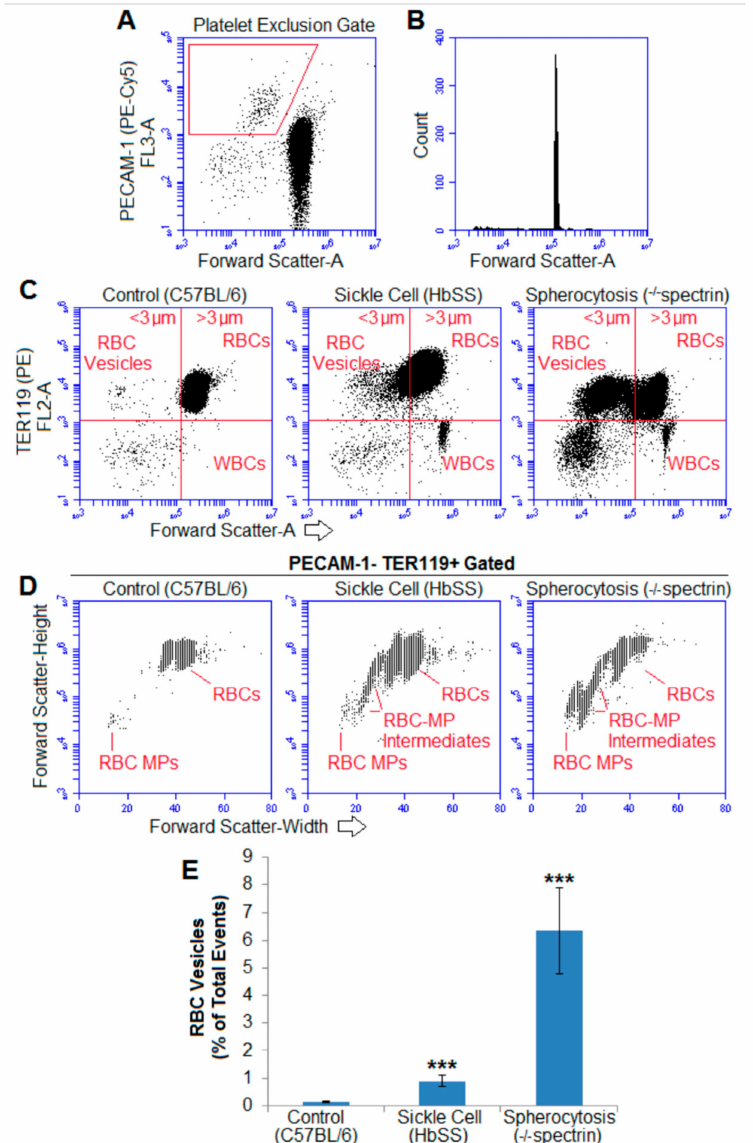
Figure 7. Blood from mouse models of hemolytic anemia contained large and heterogeneously sized vesicles: ( A ) PECAM-1+ platelets and other MPs/MVs were excluded (red trapezoid exclusion gate) and ( B ) 3 µ m beads were used to distinguish vesicles from cells (as murine RBCs are smaller than human). ( C ) Representative (PECAM-1 platelet/MV excluded) whole blood diluted 1:1000 in normal saline with 10% BSA and stained for TER119 in healthy control mice (C57BL/6), mice expressing solely human sickle hemoglobin (HbSS), and mice with deficient spectrin modeling hereditary spherocytosis. ( D ) Representative forward scatter height by width demonstrates heterogeneously sized RBC-MV intermediates in both sickle cell and spherocytosis mouse blood. ( E ) RBC vesicles smaller than 3 µ m made up nearly 1% of all events in the sickle cell mouse blood and over 6% of all events in spherocytosis mouse blood; *** p < 0.001 compared to normal mice; n = 3–5. The blood of both hemolytic mice groups showed subcellular RBC particles larger than 1 µ m. Figure 7C,D is representative flow cytometry data of the (PECAM-1 excluded) blood of 3–5 mice per genotype. (The FSC-A of 3 µ m beads is given for a size